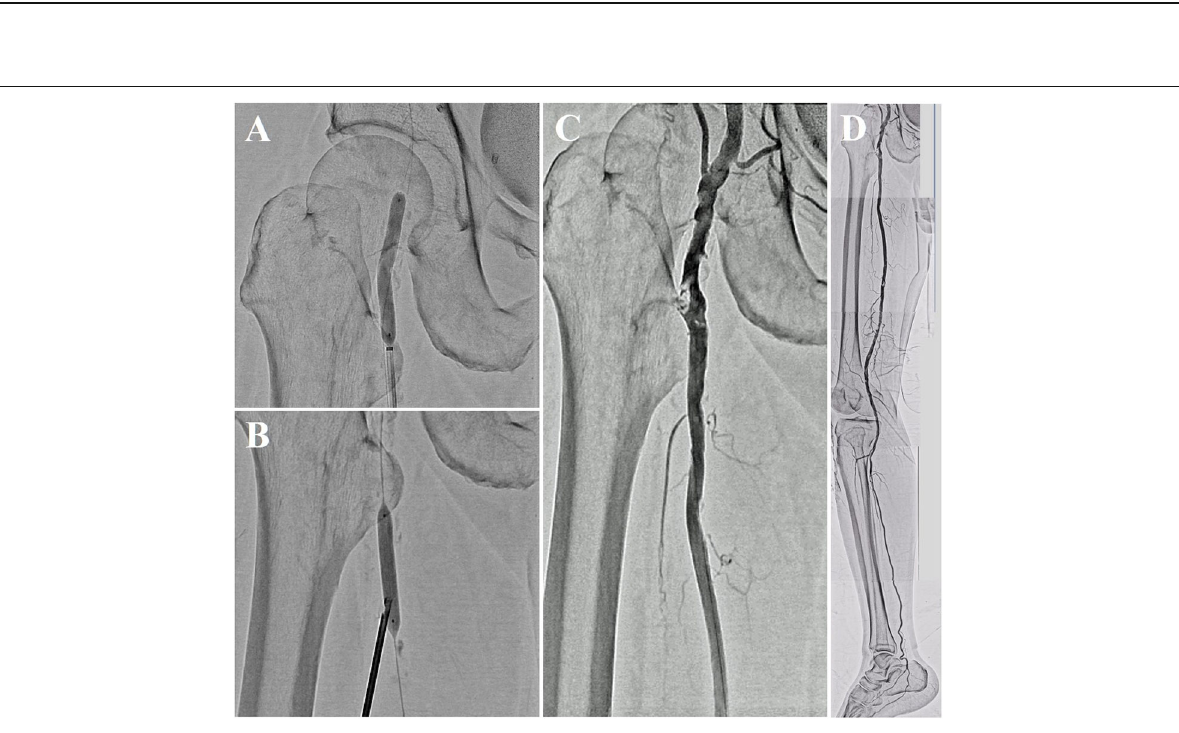
Fig. 2 Debulking nodular calcification with forceps under distal protection with a balloon-guiding catheter ( A , B ; Videos 1 and 2). After multiple debulking procedures, intravascular ultrasonography ( C ) and angioscopy ( D ) showed luminal enlargement